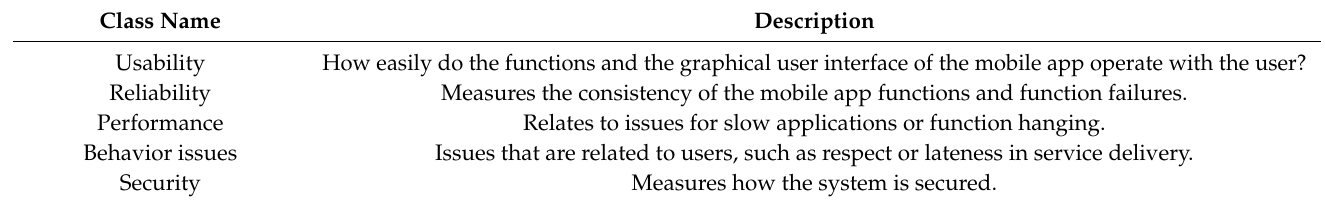
Table 4. Mobile apps issues—categories